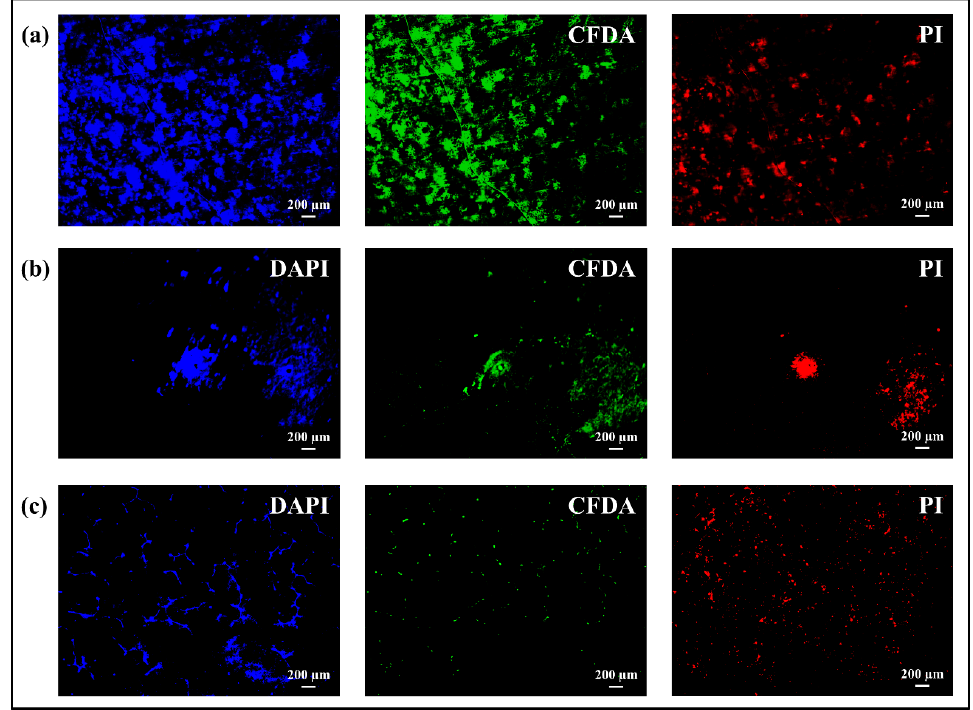
Figure 11. Fluorescence micrographs after PI, CFDA, and DAPI staining of S. epidermidis exposed for 48 h to: ( a ) Ti-alloy, ( b ) CS / PEO and ( c ) CS / PEO / BG. Live and dead cells are labeled with green and red stains, respectively, whereas nuclei display in blue color. Images were obtained at a 4X magnification.